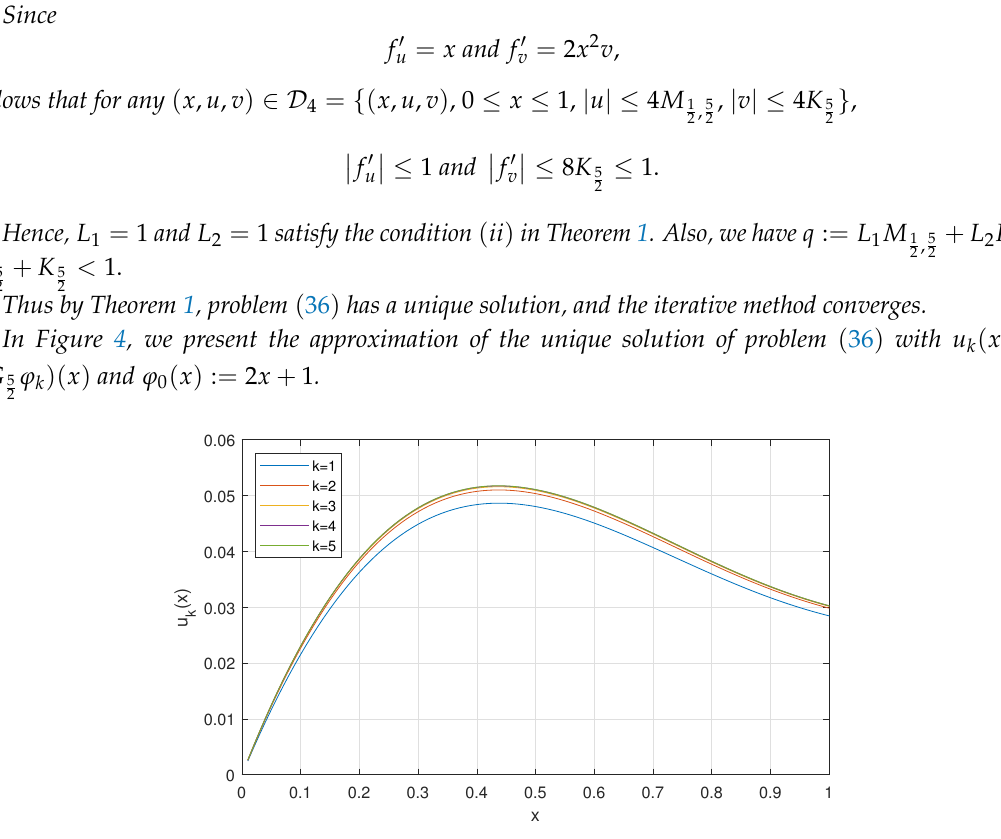
Figure 4. The approximation of the solution of problem